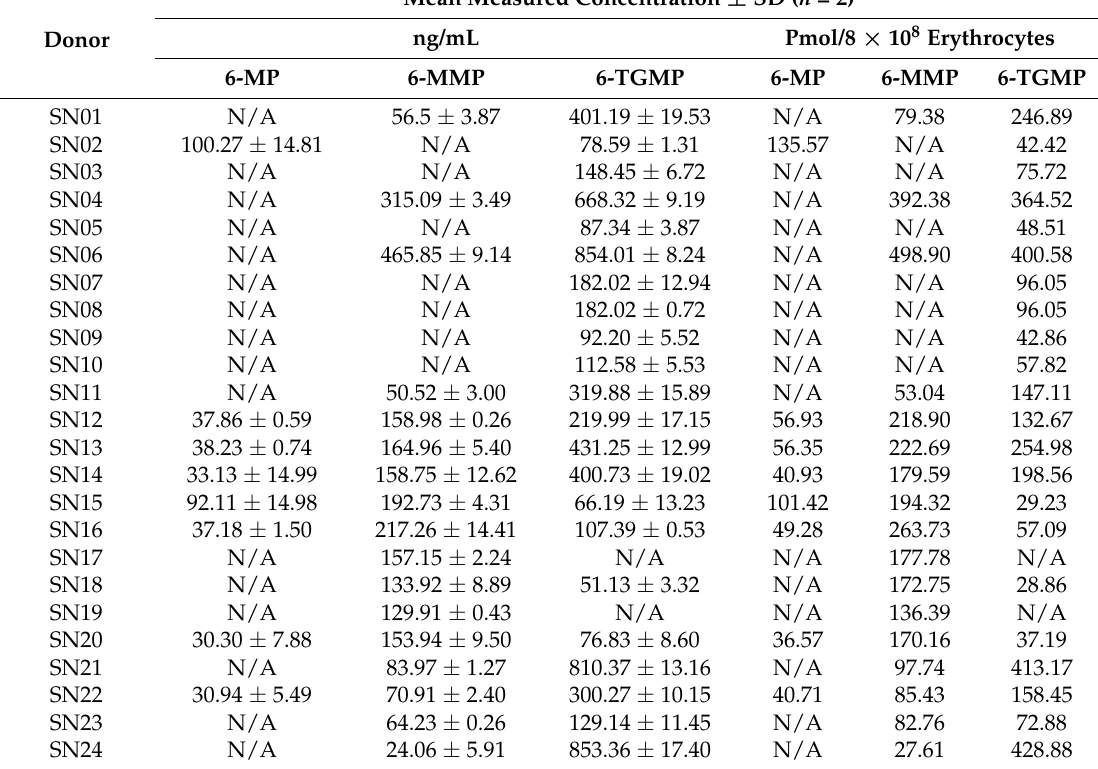
Table 1. Drug concentrations in dried blood spots (DBS) from ALL patients.